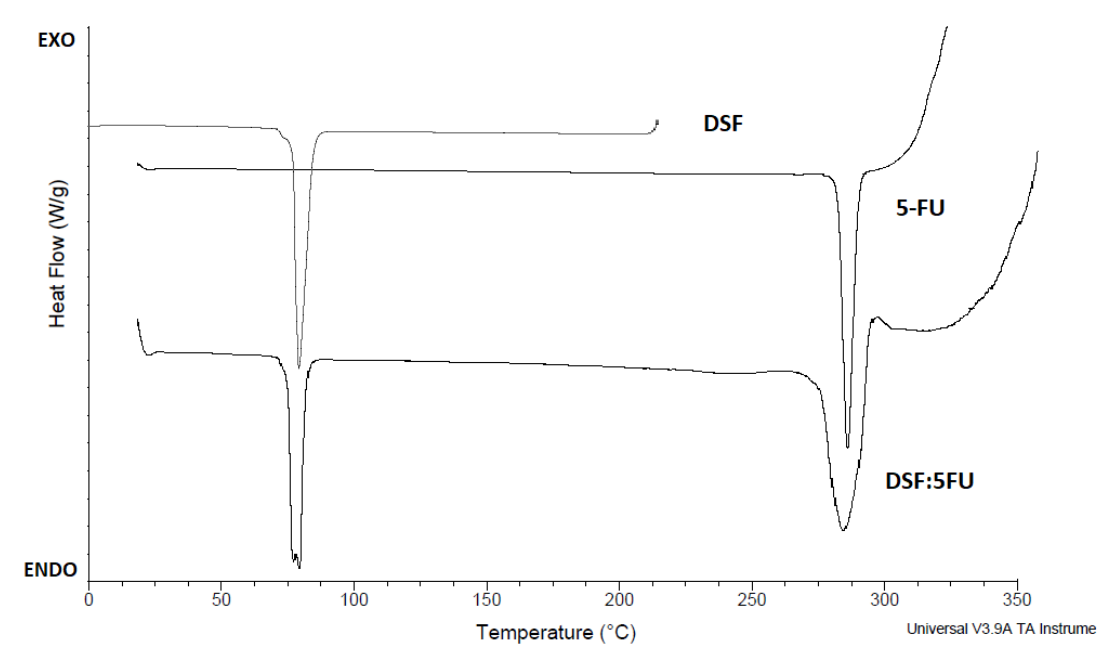
Figure 6. DSC thermogram of single drug substances and in combination.